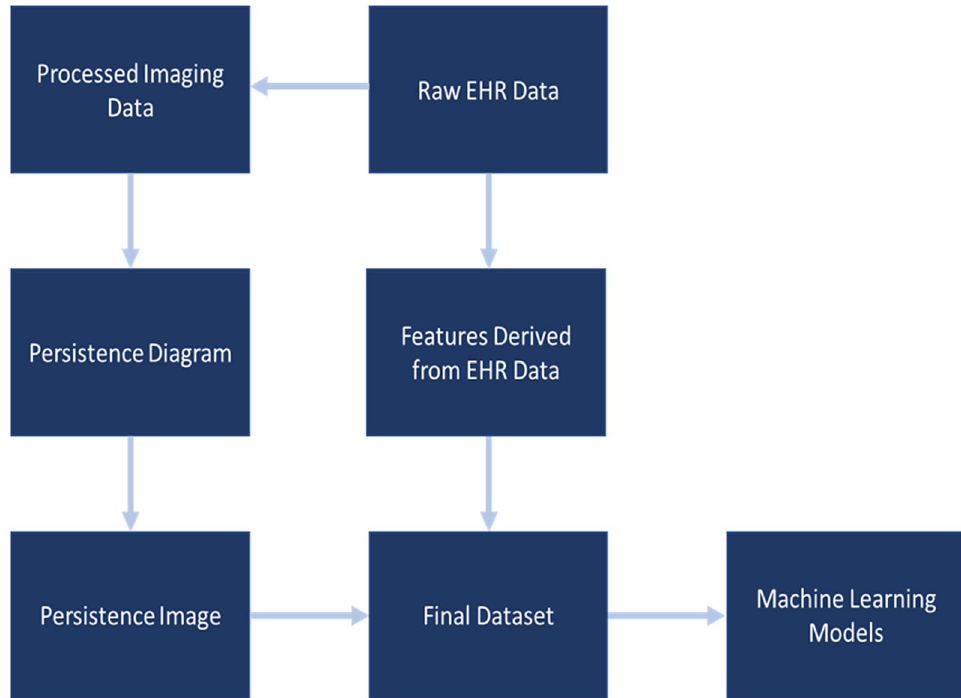
Fig. 4 Workflow for integrating PH from imaging data and raw EHR data into machine learning